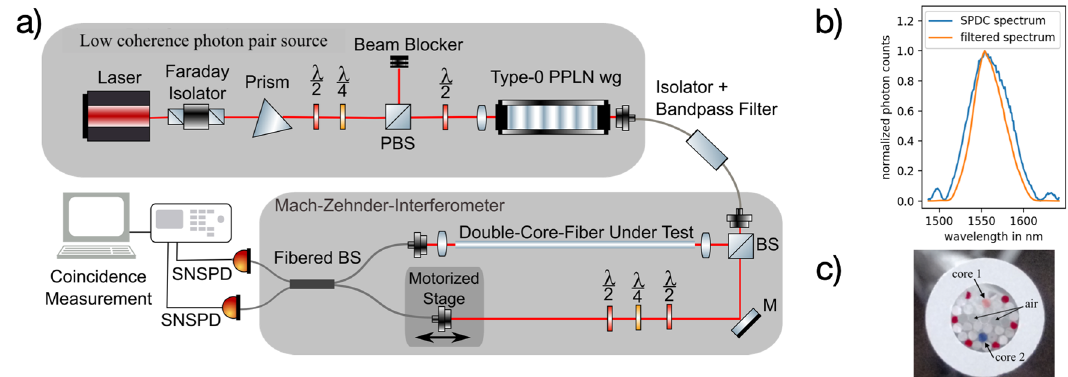
Fig. 2 Experimental setup. a A periodically poled lithium niobate waveguide (PPLN-wg) is pumped at 780 nm (CW laser) to generate entangled photon pairs. Those are spectrally bandpass fi ltered (BPF) and sent to a home-made Mach-Zehnder interferometer. One arm is adjustable and the other contains the two-core rod-type fi ber sample. The two output modes are directed to two superconducting nanowire single-photon detectors (SNSPD) that are connected to a time-to-digital converter (TDC) to record the coincidence counts. b Measured SPDC spectrum with and without the 90 nm passband fi lter. Both curves are normalized with respect to their maximum. We fi nd a FWHM of 44 nm. c Cross-section of the special two-core fi ber. There is an low refractive index barrier preventing between the two cores to avoid evanescent coupling between them. Each core has a diameter of ~10 μ m and they are separated by ~30 μ m. Core 1 (in light red) and Core 2 (in light blue) refers to the material constituting the core and the cladding of a VLMA fi ber, respectively. It is worth noting that the six red elements placed on the outermost ring of the stack are small silica rods used to ensure a good fi t of the stack into the jacketing